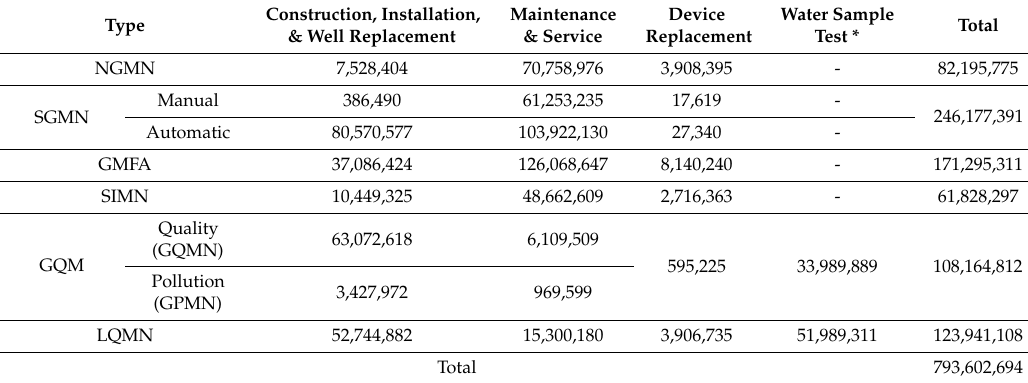
Table 5. Present values of total costs for each type of groundwater monitoring network for 50 years (Appendix